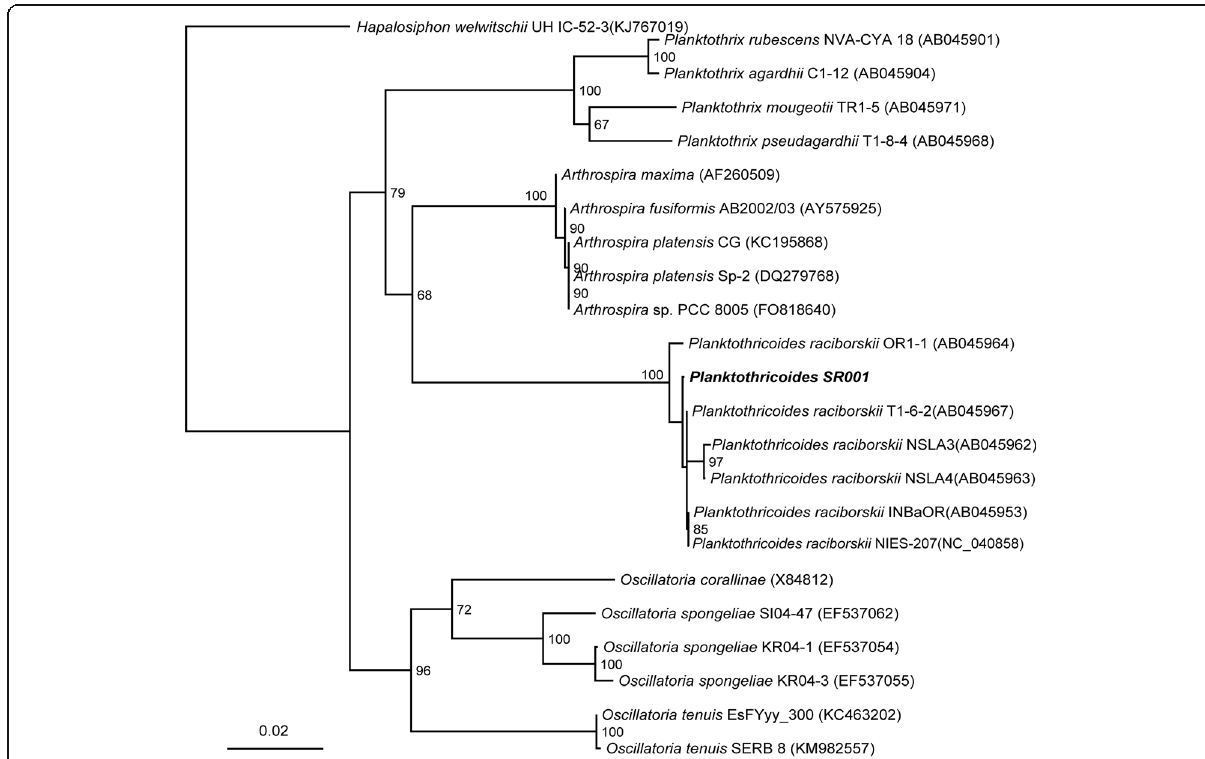
Fig. 2 Neighbor joining tree of the 16S rRNA gene of strain SR001 and selected 16S rRNA sequences of the Oscillatoriales . All 16S rRNA sequences were aligned using MUSCLE [45], manually curated, following which neighbor joining tree was constructed using the Tamura-Nei Model. Bootstrap values are labelled in each branch node and the 16S rRNA of Hapalosiphon welwitschii UH IC-52-3 was used as the